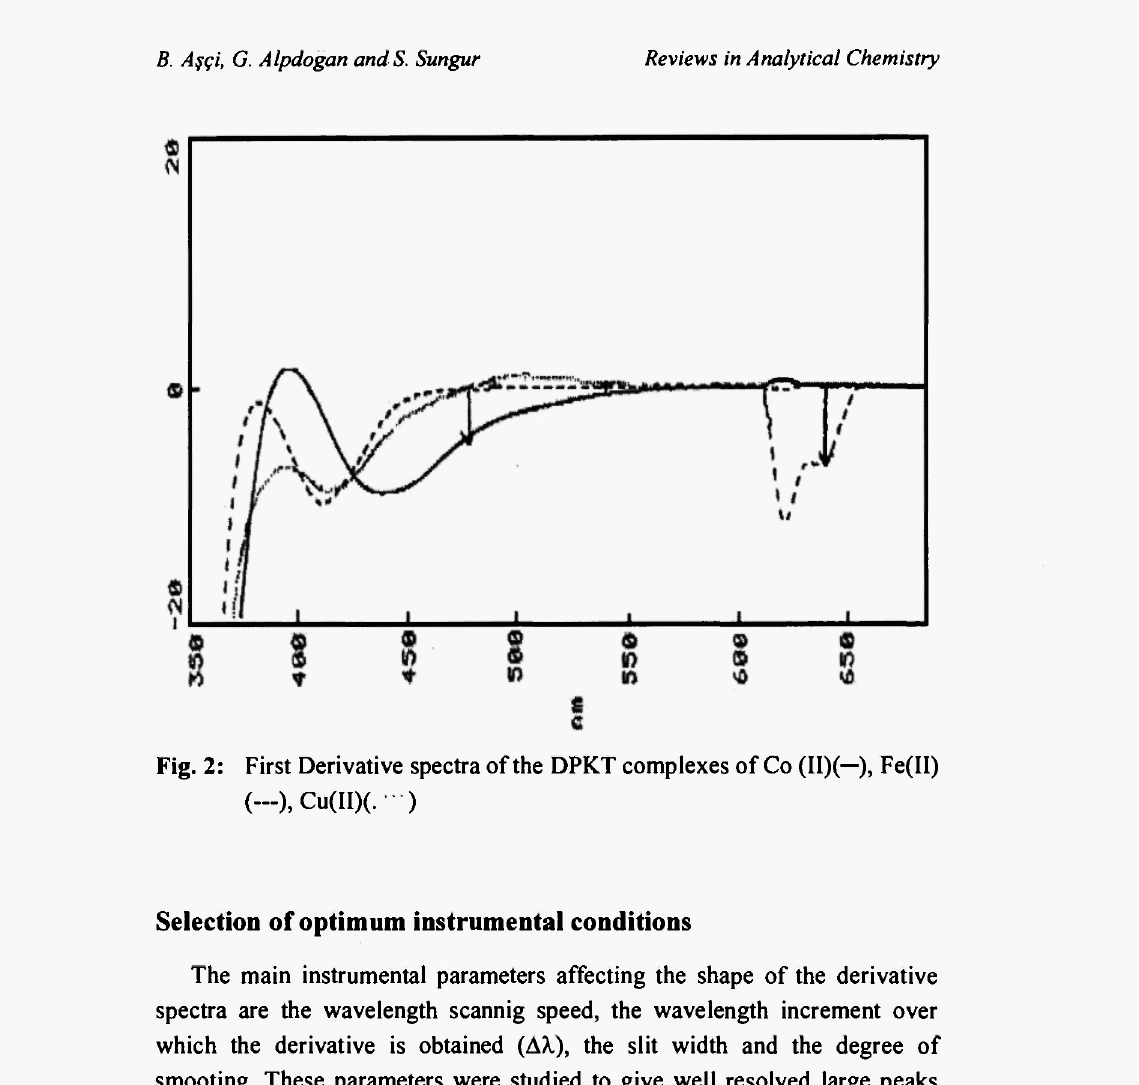
Fig. 2: First Derivative spectra of the DPKT complexes of Co (II)(— ), Fe (II) ( - ). Cu (II)(.